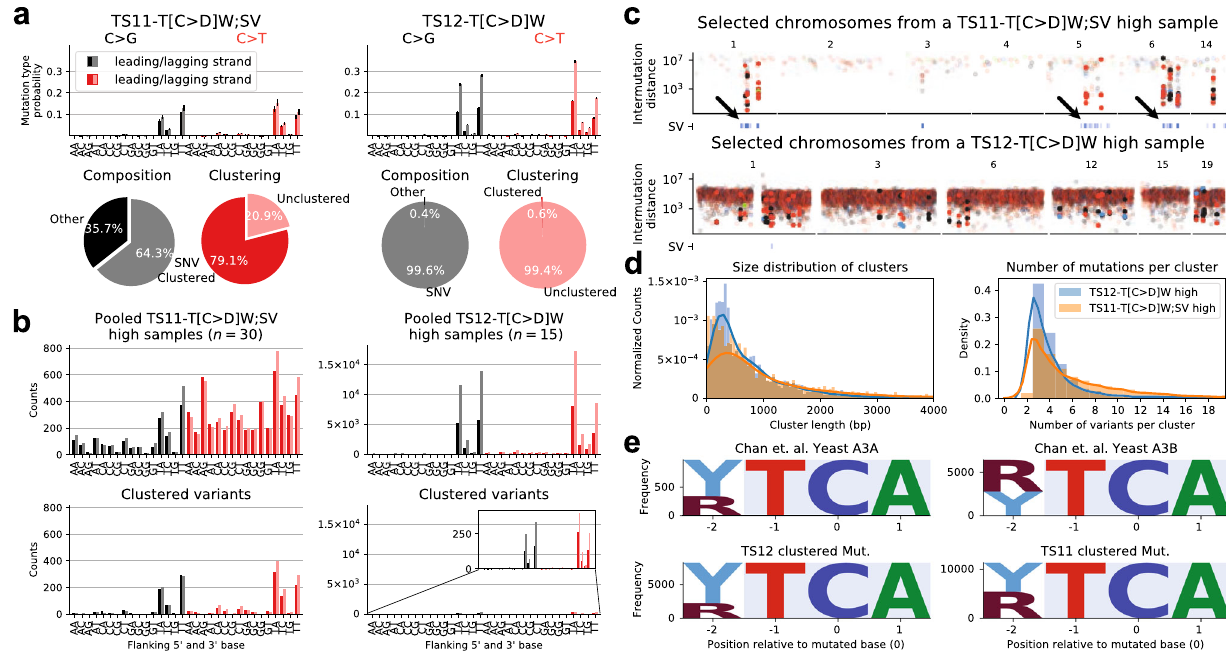
Fig. 6 Double-strand break and replication induced APOBEC mutagenesis. a C > G and C > T spectra of TS11 and TS12 for leading and lagging strand DNA (error bars determine 95% bootstrap con fi dence intervals). Pie charts underneath indicate percentages of clustered mutations and the contribution of other mutation types in TS11 and TS12. b Observed unclustered (top) and clustered variants (bottom) in TS11 and TS12 high samples (TS11 and TS12 contributions > 10% and 70% respectively). c Rainfall plots with SV annotations from a typical sample with high TS11 (top) and TS12 contributions (bottom). d Size distribution of mutation clusters (consecutive clustered mutations), and the distribution of number of variants per mutation cluster in TS11 and TS12 high samples respectively. Curves depict corresponding kernel density estimates. e Motif logo plots of the tetranucleotide context at mutated TCA sites in yeast cells exposed to APOBEC3A/3B mutagenesis respectively 27 , and similar motif logo plots extracted at clustered mutations from samples with high TS11 or TS12 exposures. Source data are provided as a Source Data fi